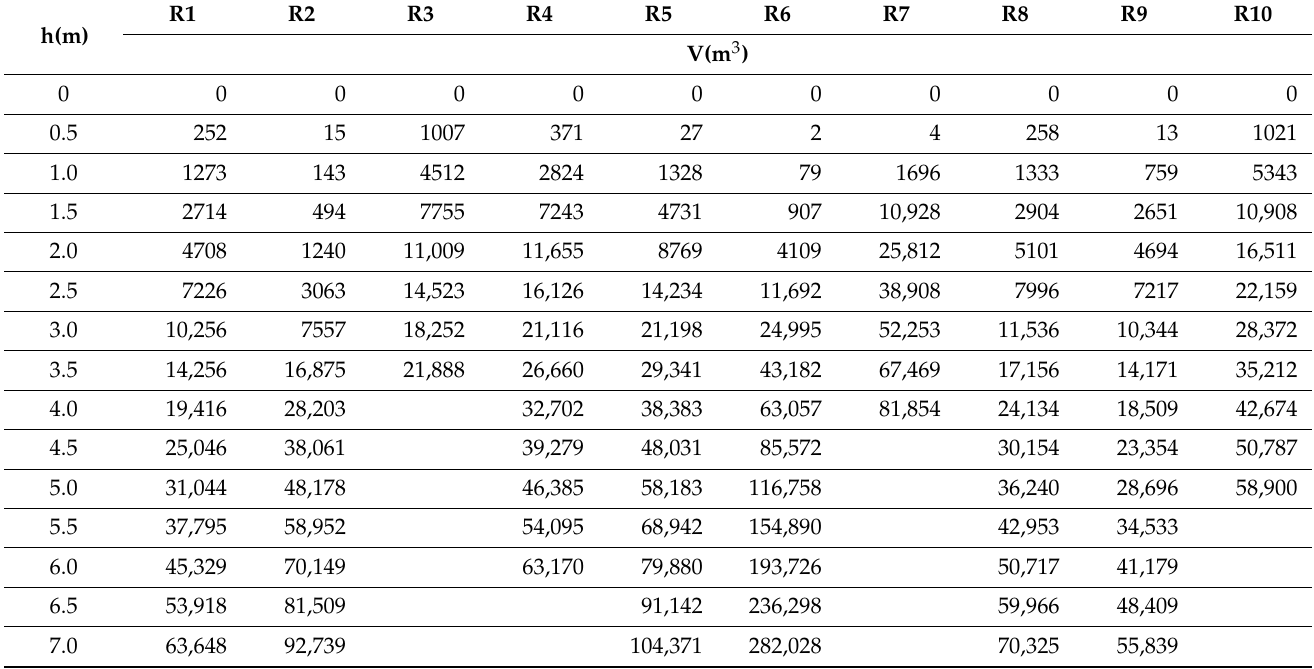
Table 4. Volume estimations according to the change in reservoir